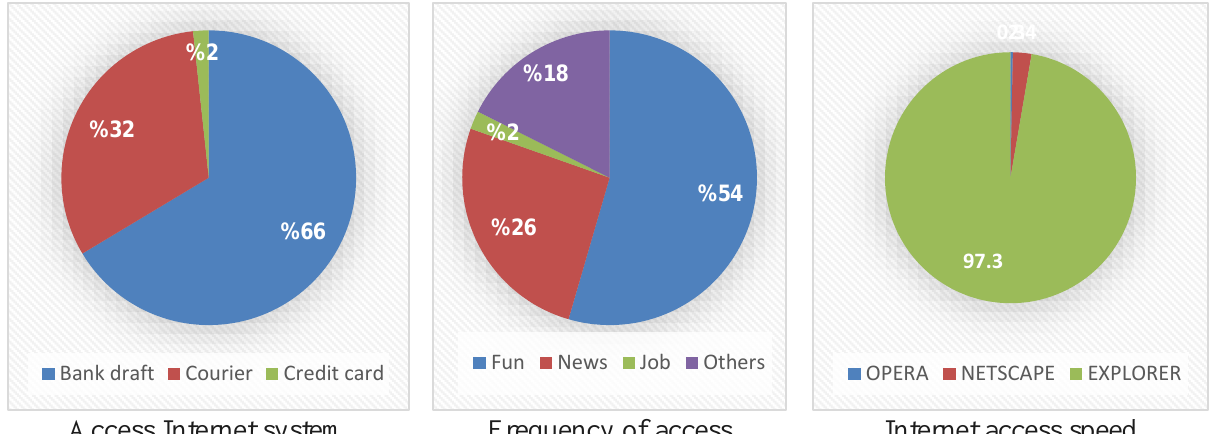
Fig. 3. Characteristics of the participants’ Internet